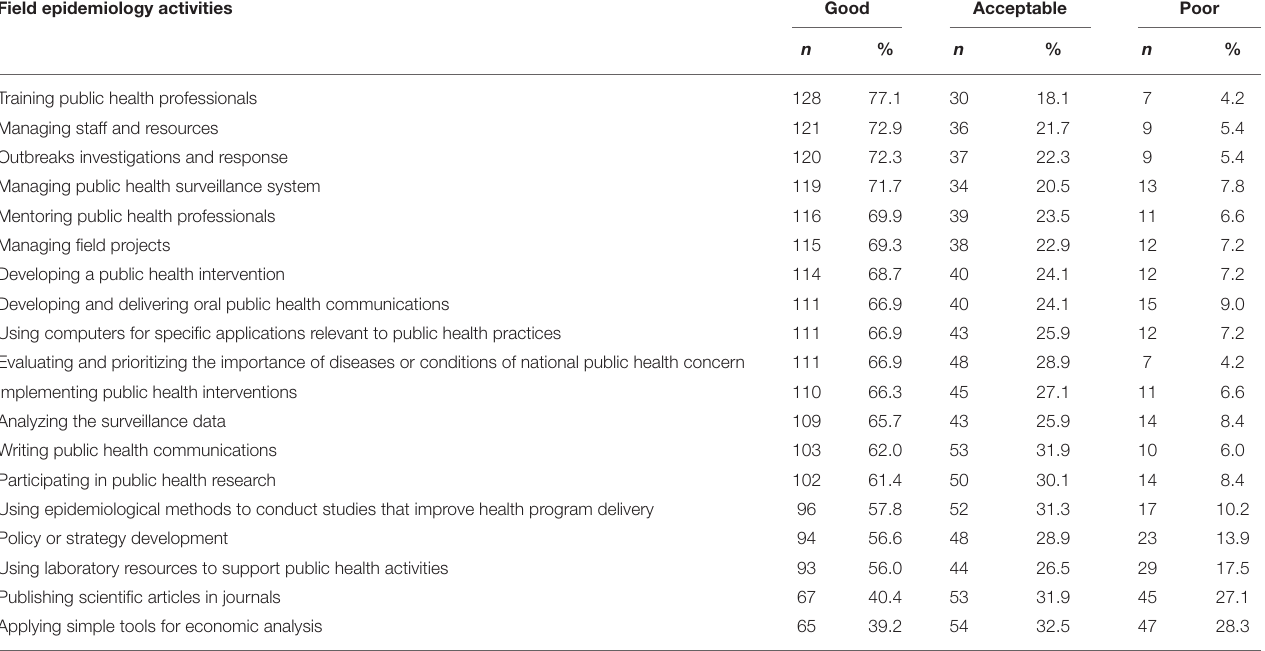
TABLE 4 | Self-evaluation of FETP graduates of their skills in performing field epidemiology